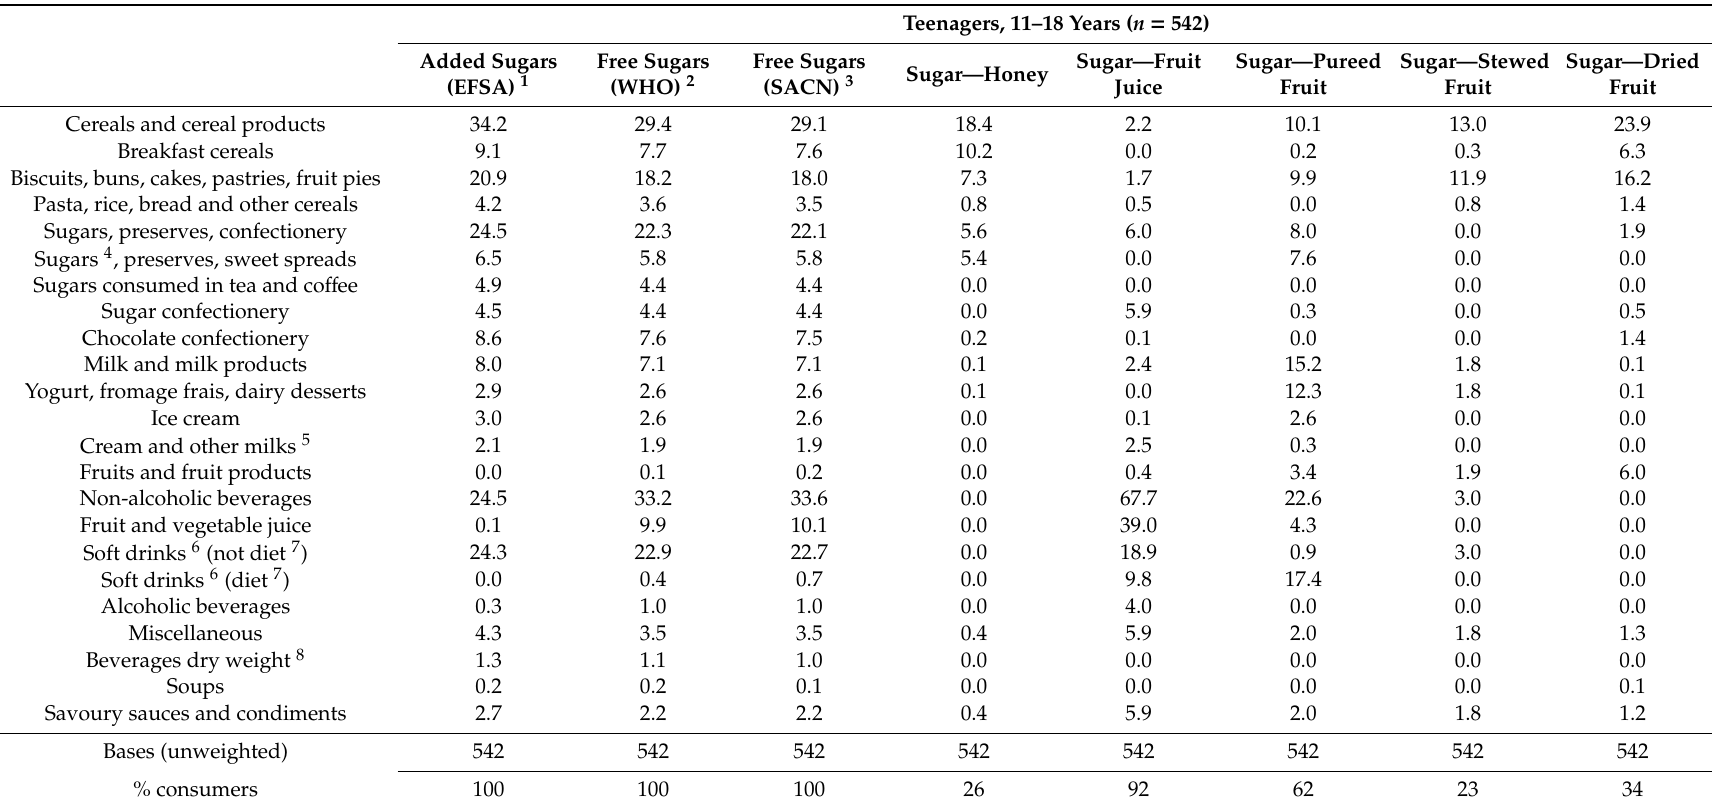
Table 6. Contribution (%) of NDNS RP food group sources to intake of sugars by age (11–18 Years) (NDNS